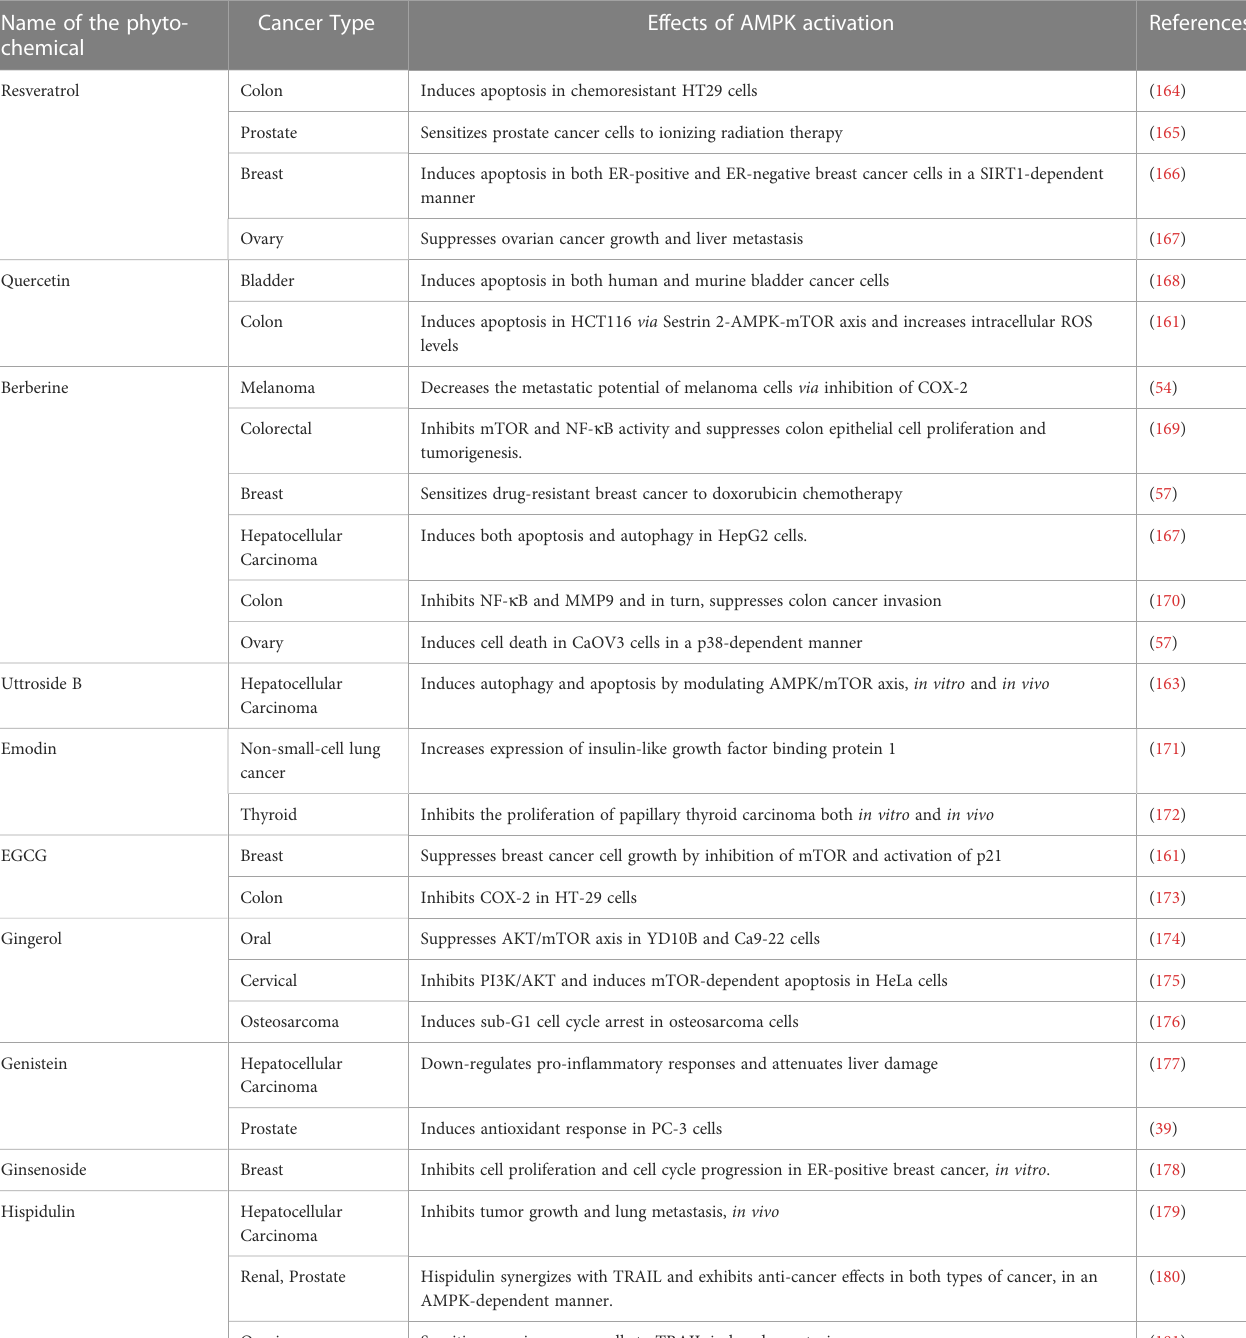
TABLE 2 The implications of AMPK activation in various cancer types mediated by some of the major plant-derived anti-cancer agents. Name of the phyto-